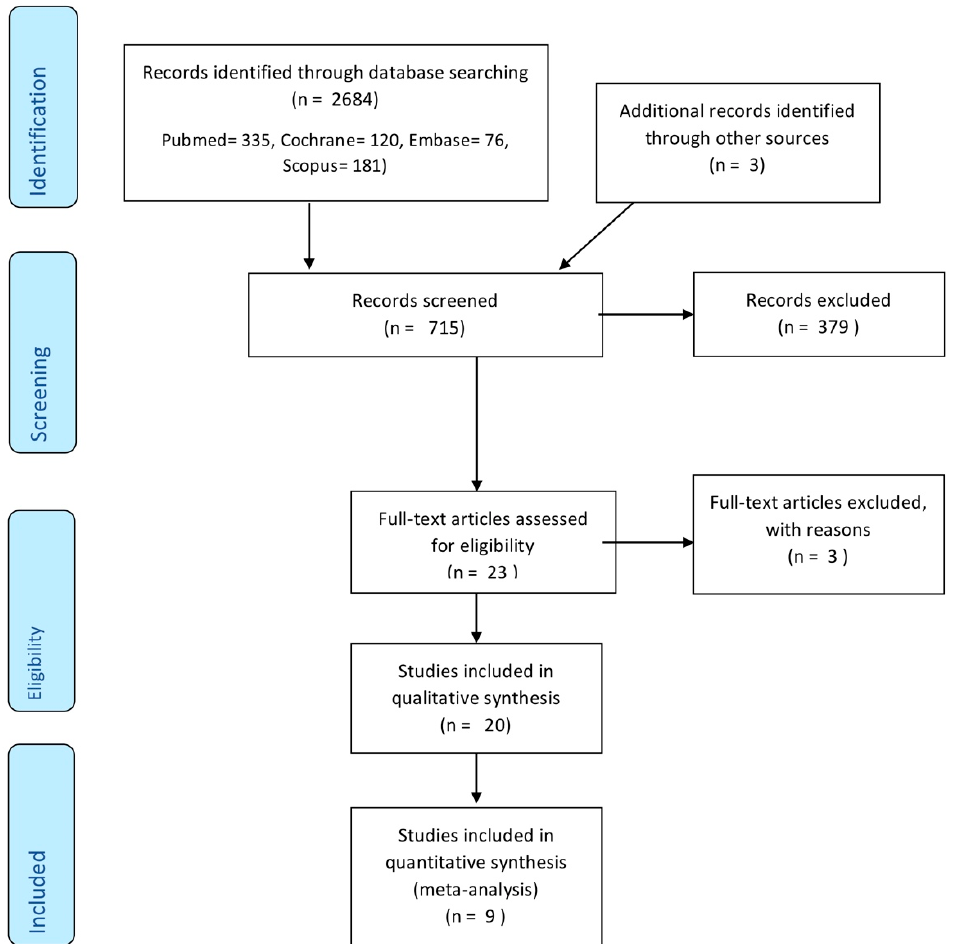
Figure 1. Flow chat of study selection procedure.